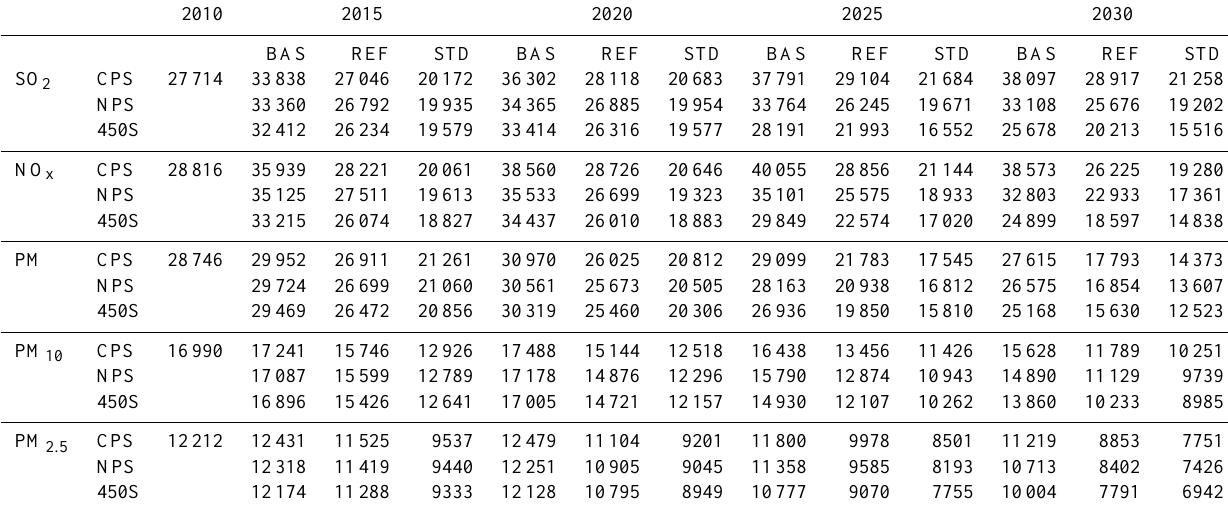
Table 3. Projected national emissions of anthropogenic SO 2 , NO x , and PM for 2015, 2020, 2025 and 2030 by scenario (unit: Gg). The emissions of 2010 (Y. Zhao et al., 2013) are listed as well for